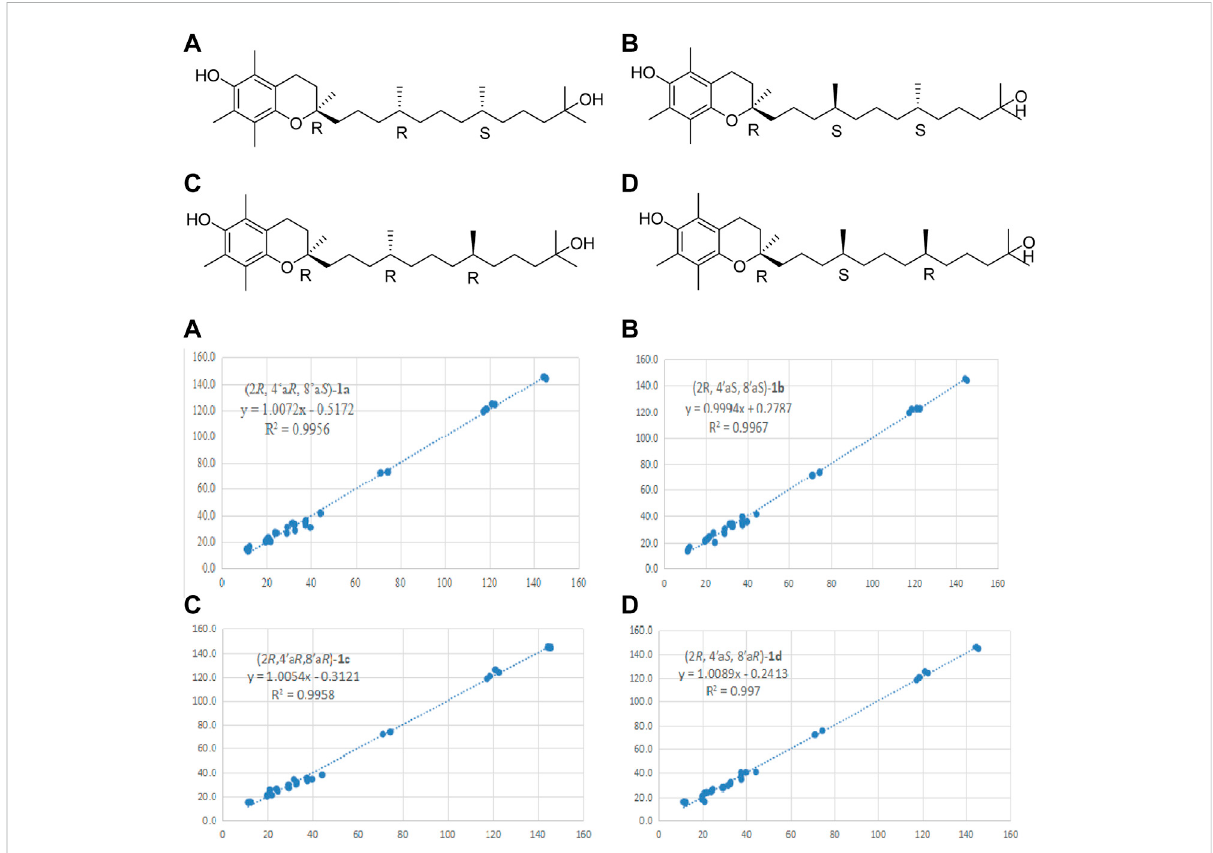
FIGURE 4 Linear regression fi tting of computed 13 C-NMR chemical shifts of the calculated con fi guration of compound 1 with the experimental values.